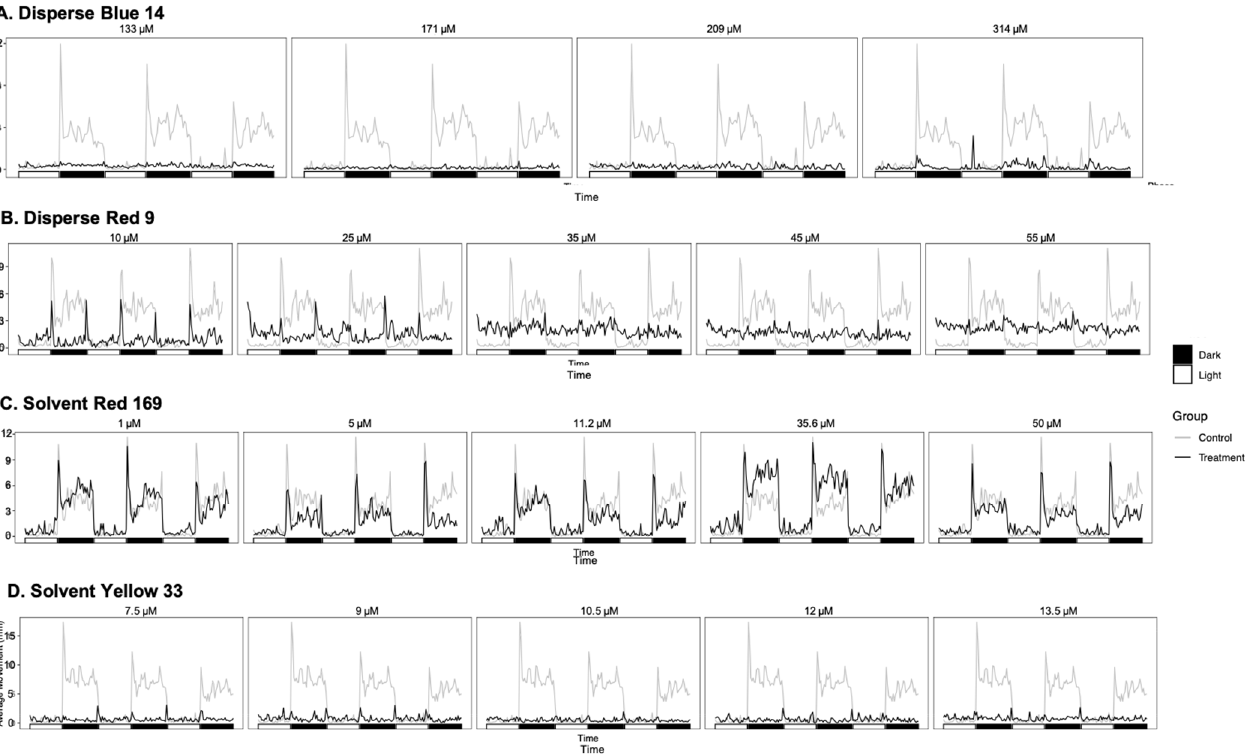
Figure 3. Average movement of the ( A ) Disperse Blue 14, ( B ) Disperse Red 9, ( C ) Solvent Red 169 and ( D ) Solvent Yellow 33 treatment groups throughout the photomotor assay.